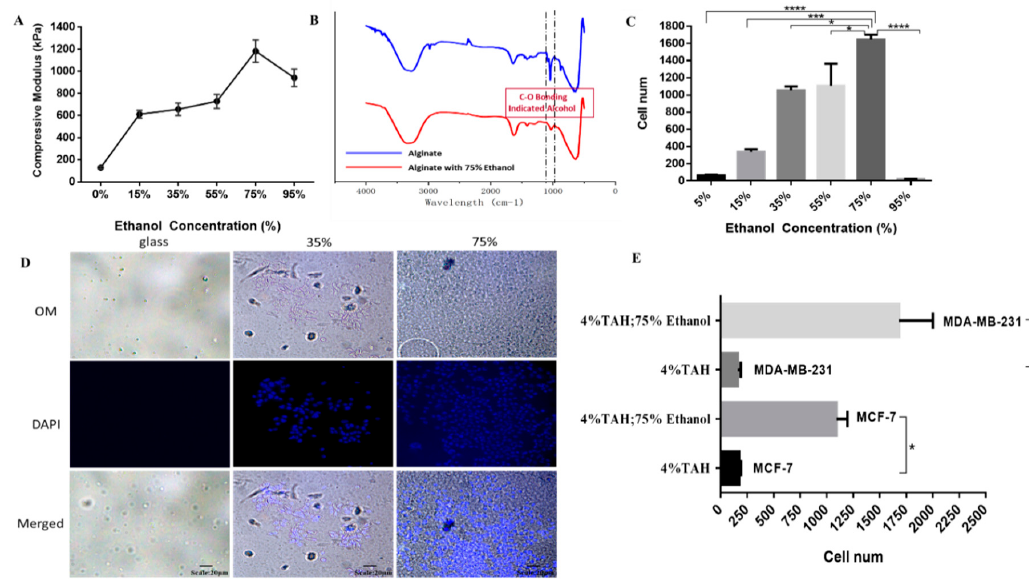
Figure 4. Biophysical parameters of TAH and cancer cell homing in this model. ( A ) The compressive modulus of TAH treated with different concentration of ethanol. ( B ) The FTIR absorption spectra of TAH (blue) and 75% ethanol-treated TAH (red). The range of hydroxyl group is from 1000 to 1100 cm − 1 , indicated by dotted lines. ( C ) The cell number of MDA-MB-231 homed to alginate hydrogel films pretreated with different concentrations of ethanol. Experiments were performed in triplicate. A two-tailed unpaired ANOVA with Tukey’s HSD post hoc test. * p < 0.05, *** p < 0.001, **** p < 0.0001. ( D ) Images of cell attached on hydrogel films treated with 35%, 75%, and 95% ethanol, respectively. Nuclei were stained by DAPI and observed by fluorescence microscopy with the magnification of 100x and shown in blue. Scale bar is 20 μ m. ( E ) The cell number of attached MCF-7 & MDA-MB-231 on 4% alginate hydrogel films with or without ethanol treatment. This experiment was performed in triplicate. ANOVA with Tukey’s HSD post hoc test. * p < 0.05 , *** p < 0.001.